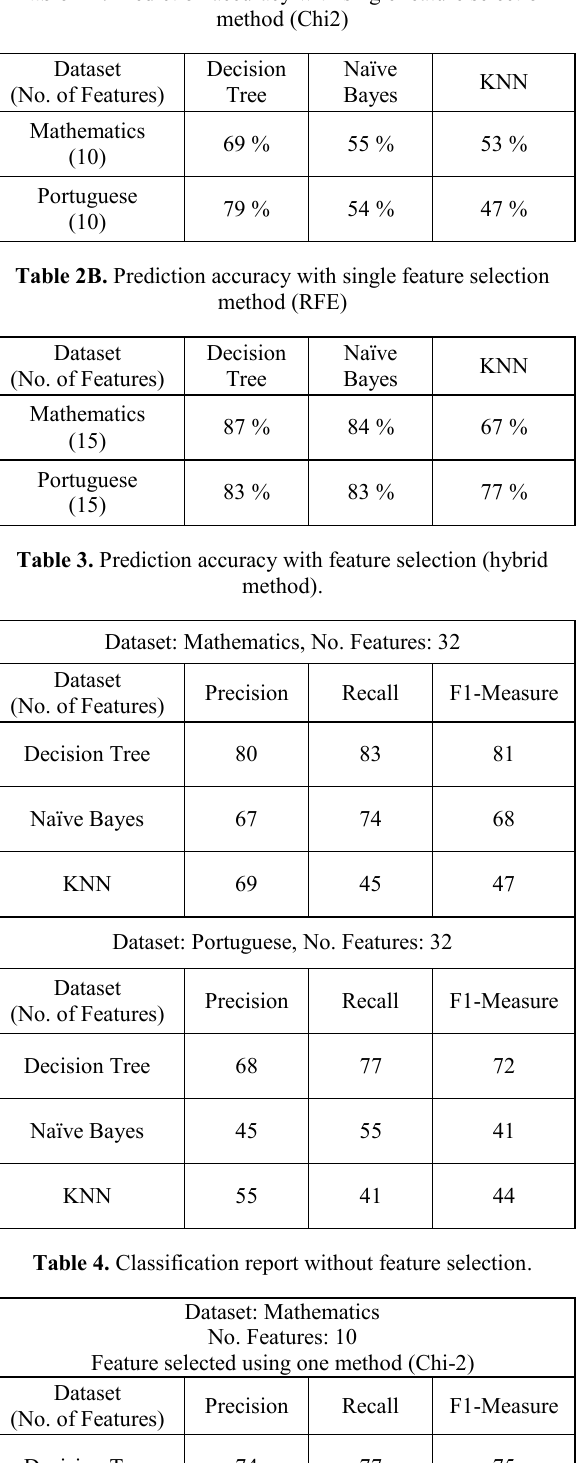
Table 2A. Prediction accuracy with single feature selection